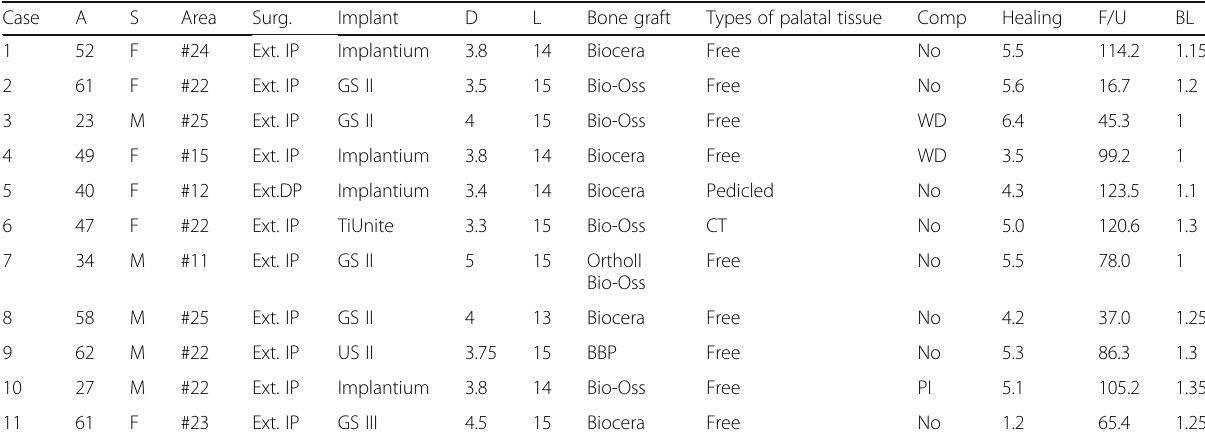
Table 1 Socket sealing with palatal tissue grafting